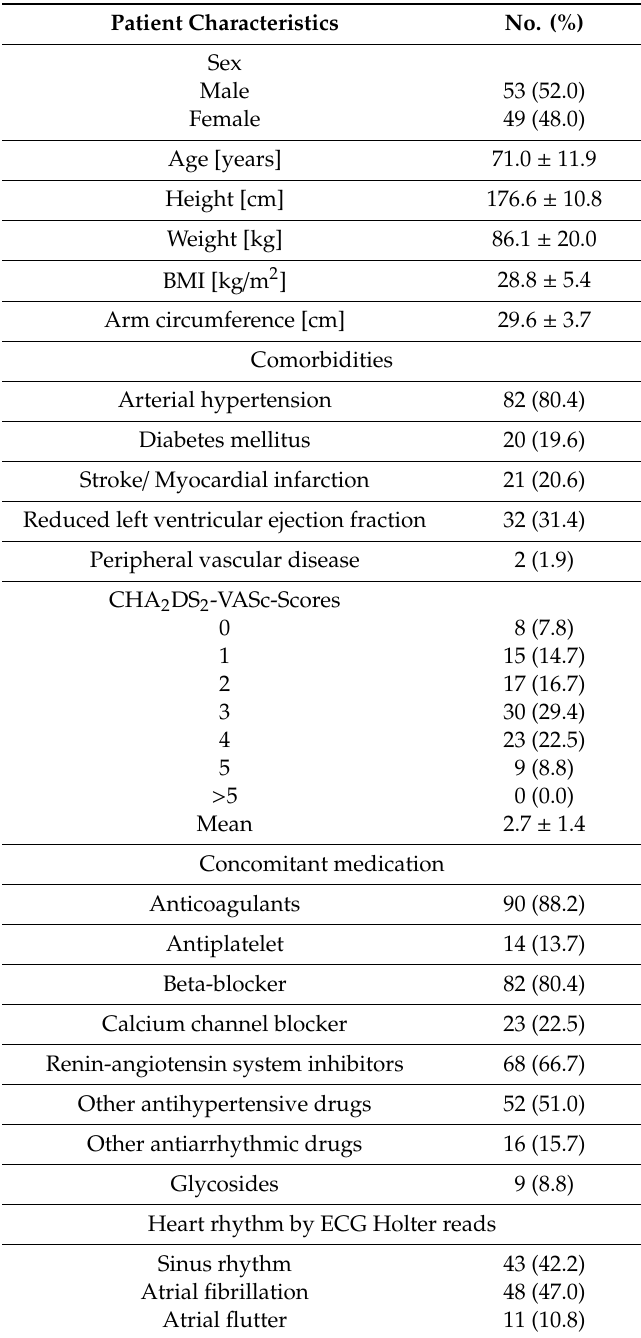
Table 1. Demographics, comorbidities, concomitant medication, and CHA 2 DS 2 -VASc Score of patients